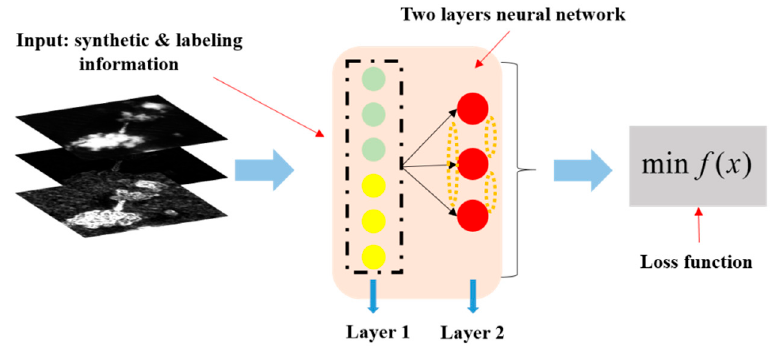
Figure 9. The generation process of the one-dimensional topological map.